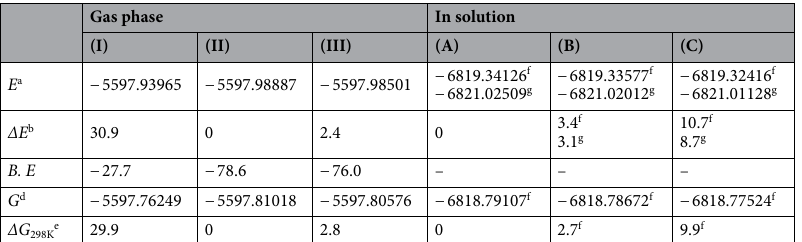
Table 1. Thermodynamic properties of permethylated β-CD–protonated L-Lys complexes in gas phase ((I)– (III)) and in solution ((A), (B), (C)). a Electronic energy in Hartree, wB97X-D/6-311G**. b Relative electronic energy in kcal/mol, wB97X-D/6-311G**. c Gas phase binding energy ( H complex – H host – H guest ) in kcal/mol. d Gibbs free energy at 298 K in Hartree. e Relative Gibbs free energy in kcal/mol. f wB97X-D/6-31G**; g wB97X-D/6- 311G**